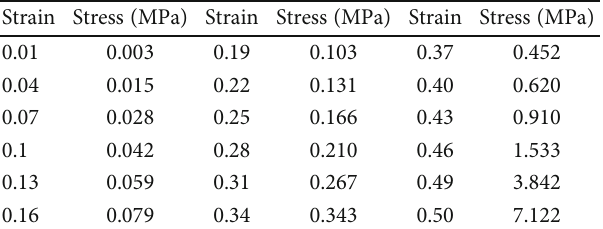
Table 3: Stress – strain relationship of the goaf medium in the double-yield